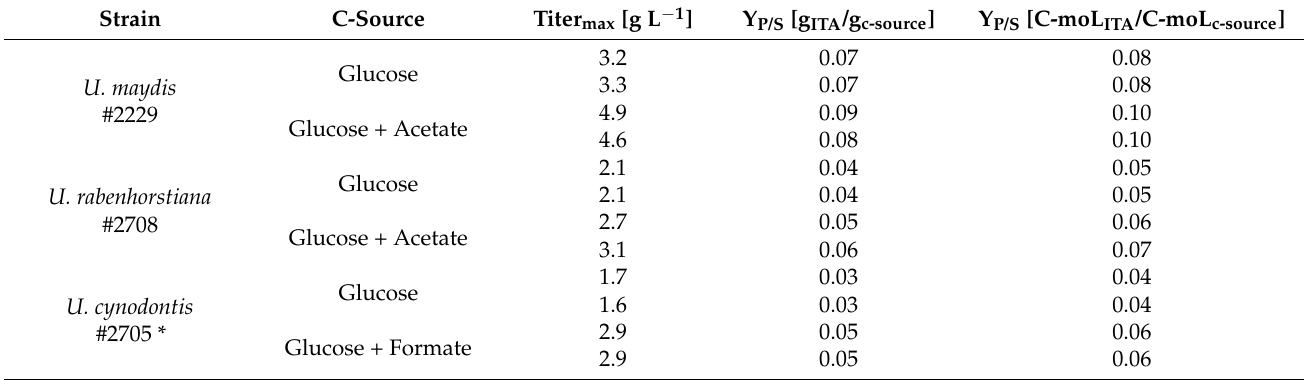
Table 1. Production parameters of controlled-batch fermentations of U. maydis #2229, U. rabenhorstiana #2708, and U. cynodontis #2705. Fermentation experiments were performed in a bioreactor containing MTM medium with 50 g L − 1 glucose, 0.8 g L − 1 NH 4 Cl, at 30 ◦ C, 80% DOT, and pH 6.5. Co-substrates (acetate, formate) were added with 6.25 g L − 1 . Statistically significant differences in itaconic acid production ( p ≤ 0.05) are indicated as *. Details of statistical analyses are displayed in Table